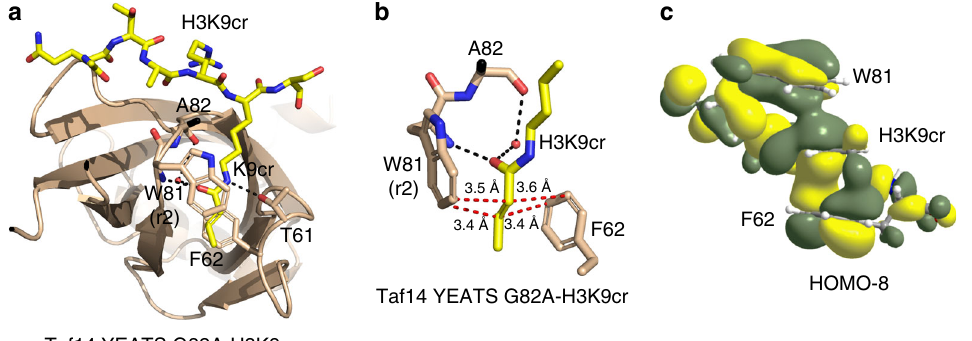
Fig. 3 Structural basis for recognition of crotonyllysine by Taf14-YEATS G82A. a The ribbon diagram of the Taf14-YEATS G82A:H3K9cr complex. Dashed lines and red sphere represent hydrogen bonds and a water molecule, respectively. b Close up view of the H3K9cr-binding site of Taf14-YEATS G82A. Red dashed lines represent short distances indicative of the aromatic-aliphatic-aromatic π stacking interaction. c A representative HOMO-8 (see also Supplementary Figure 6) NATURE COMMUNICATIONS| (2018) 9:4574 |DOI: